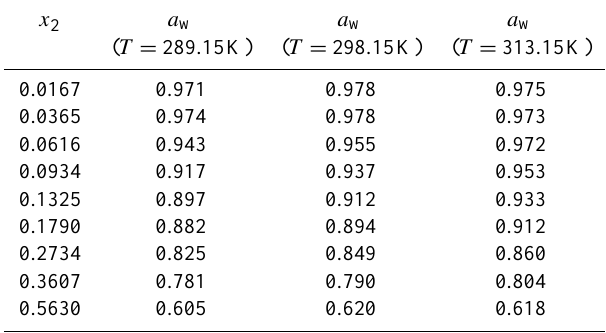
Table A2. Bulk water activity (a w ) measurements a of water (1) + 2,5-hexanediol (2) solutions at three different temperatures. Solution compositions are given in mole fraction of the organic component (2), x 2 . x 2 a w